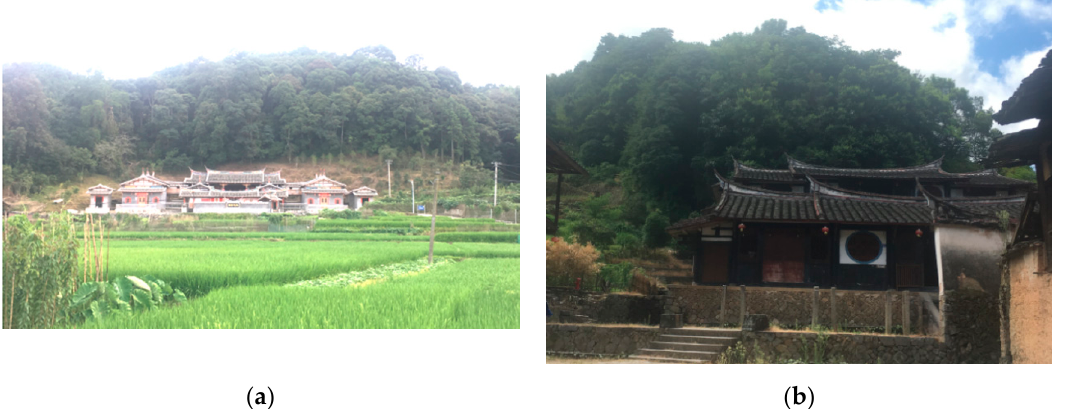
Figure 6. Fengshui forests around ancestral halls in ( a ) Zhongxian Village on the left and ( b ) Guifeng Village on the right.